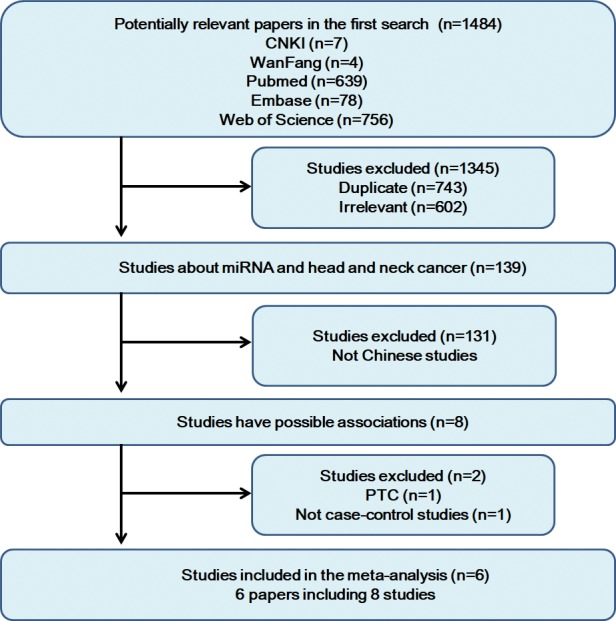
The flow diagram of included/excluded studies.